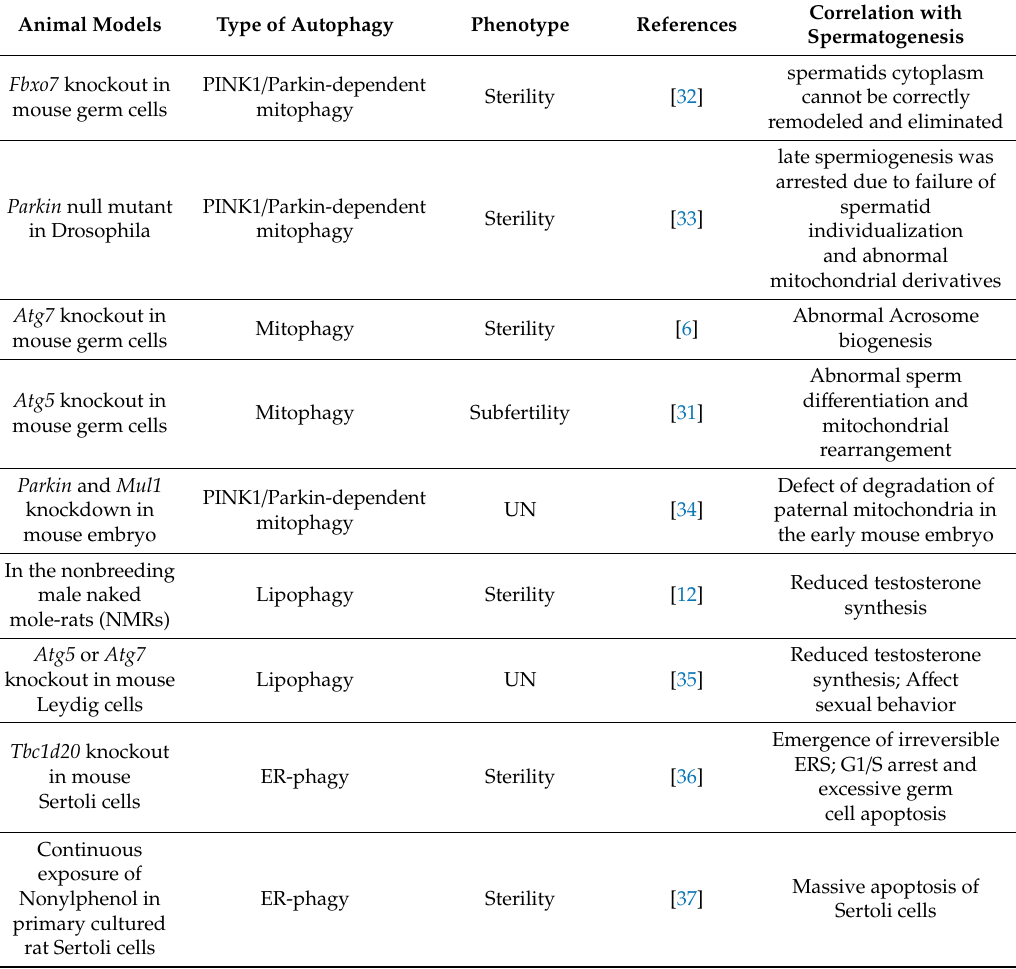
Figure 2. Mitophagy is involved in spermatid differentiation. In the process of spermiogenesis, excessive mitochondrion in the residual bodies will be cleared by mitophagy, and the remaining mitochondrion will rearrange in elongated tubules and participate in the formation of spermatozoa. Table 1. Mutant animal models and the role of selective autophagy on spermatogenesis and male fertility in the main studies of this review.